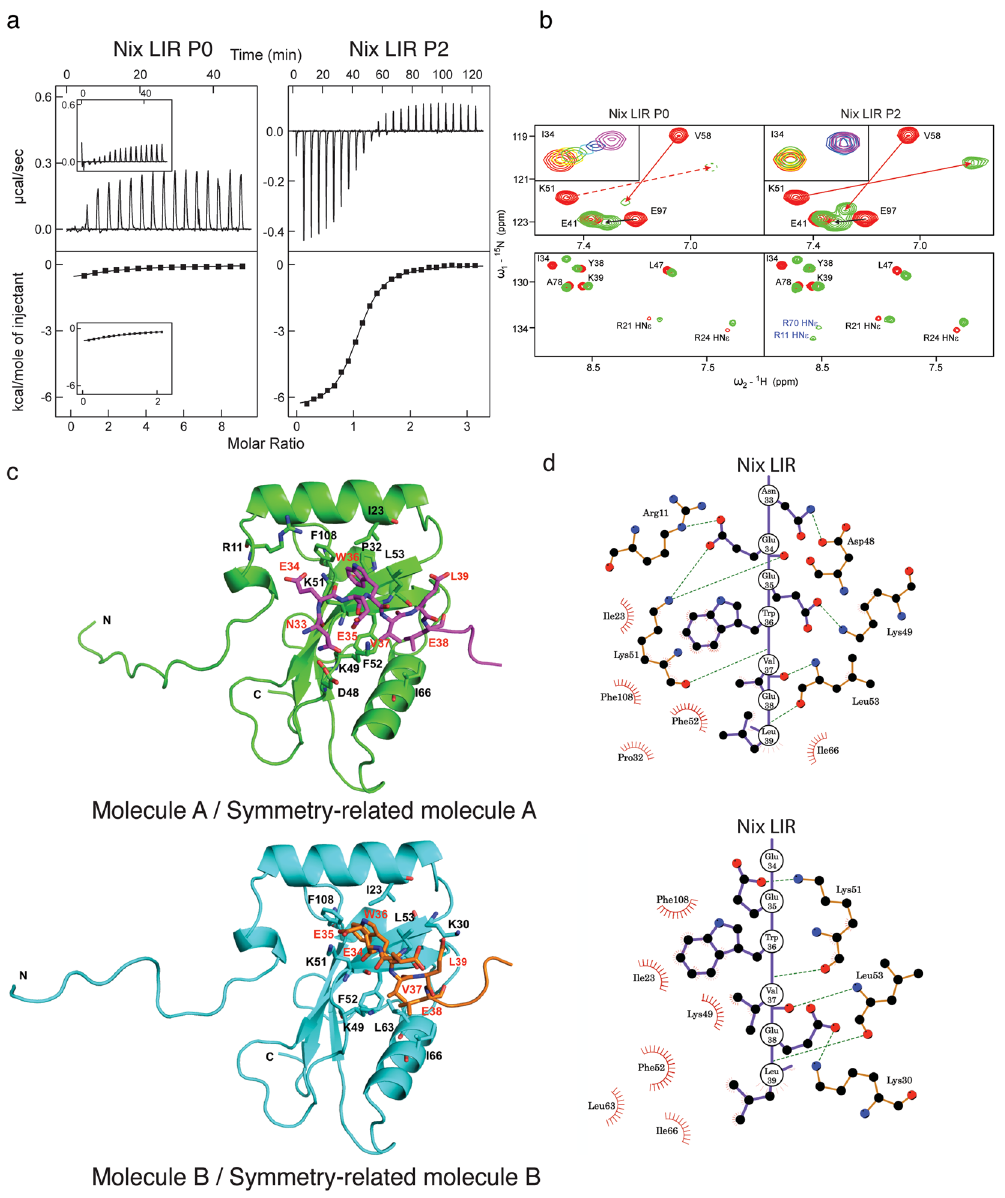
Figure 2. Influence of Nix phosphorylation on its interaction with LC3B studied by ITC, NMR and crystallography. ( a ) ITC profiles for the titration of Nix LIR P0 (left) and Nix LIR P2 (right) peptides into LC3B are shown at the main plots in the same scales of energy. For comparison, ITC data from Novak et al . 17 , representing LC3B titration with P0, are shown in the small windows within corresponding plot. In each plot the top diagram displays the raw measurements and the bottom diagram shows the integrated heat per titration step. ( b ) Upper plots: Representative sections (“fingerprint area”) of 15 N-labeled LC3B [ 15 N, 1 H]-TROSY HSQC spectra in the free LC3B state (red contours) and in complex with Nix LIR P0 and P2 peptides (green contours). Arrows show direction of CSP for selected residues. Dashed lines represent CSP of the K51 HN resonance, which cannot be visualized at this experimental series. Small windows within the plots represent exchange modes for the characteristic LC3B residues Ile34 upon P0 and P2 peptides titrations (rainbow color-code). Low plots: Representative spectral section showing arginine HN ε side-chain resonances. They are aliased in the ω 1 dimension and appear at a 15 N chemical shift 50 ppm downfield from their true position. Tentative assignment for the HN ε side-chain resonances appeared upon P2 titration is given in blue. ( c ) Structure of Nix/ LC3B complex. Structures of Nix-LIR S34,35E -LC3B 2–119 molecules A and B are represented by ribbon diagrams and colored in green (molecule A) and cyan (molecule B). Nix LIR portions in symmetry-related molecules (molecule A, magenta; molecule B, orange) and its interacting residues are shown in stick representation. Oxygen, nitrogen and sulfur atoms are shown in red, blue and yellow, respectively. Schematic representations showing the interaction between LC3B and Nix LIR S34,35E on level of residues were generated by LIGPLOT 35